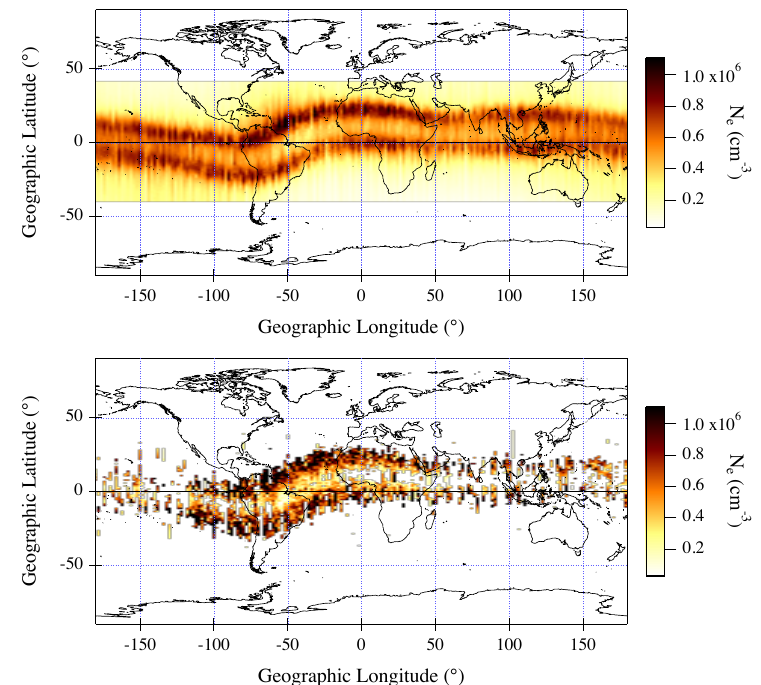
Figure 1. Top panel : Global accumulated plot of N e values as recorded on board Swarm A from April 2014 to 31 January 2016, for Kp ≤ 3 and between 18:00 and 24:00 LT. Bottom panel : Accumulated plot of the subset of N e values corresponding to IBI = 1 and BF = 1, and therefore to the presence of plasma bubbles, over the same time interval considered in the top